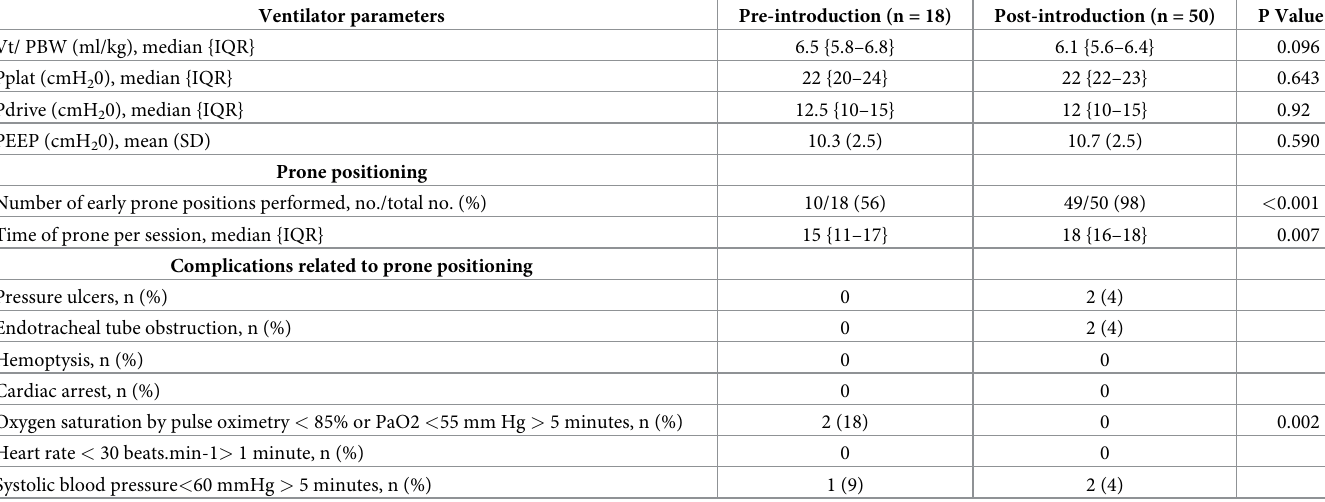
Table 2. Parameters of ventilation and prone positioning and complications related to prone positioning.